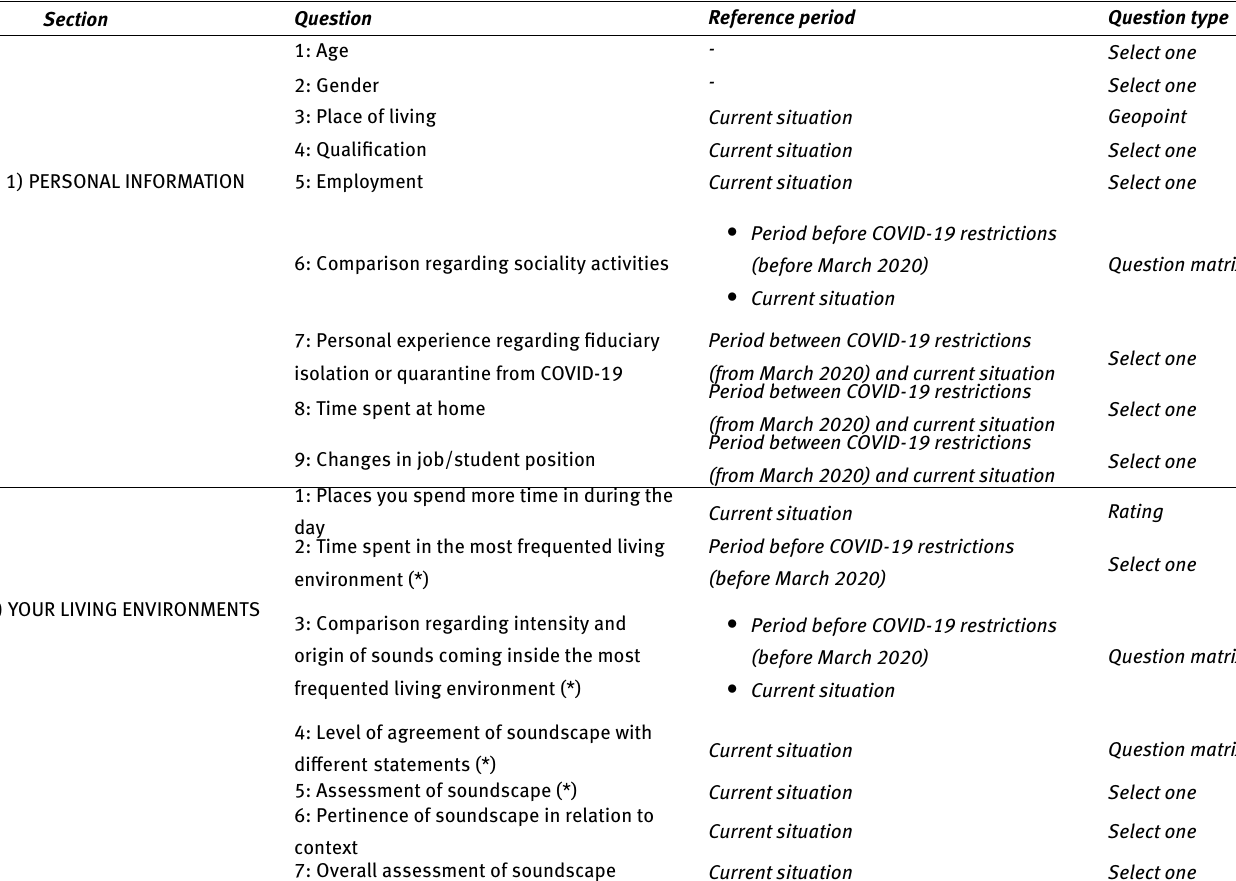
Table 1: Contents of the questionnaire “Urban Sound during the pandemic: has COVID-19 changed our soundscape perception?”.